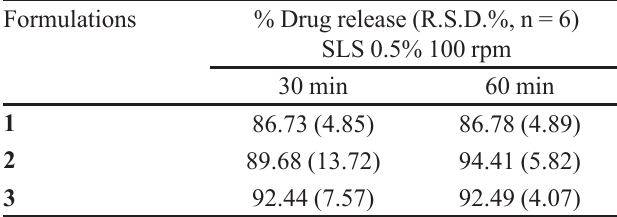
Table VII - Mean percent drug release from the three formulations in SLS 0.5% (w/v) dissolution medium